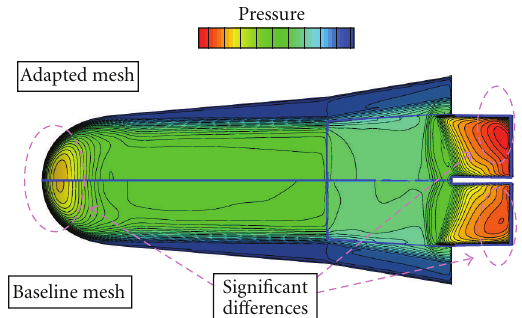
Figure 3: The ESA IXV vehicle: pressure distribution over the windward side of the